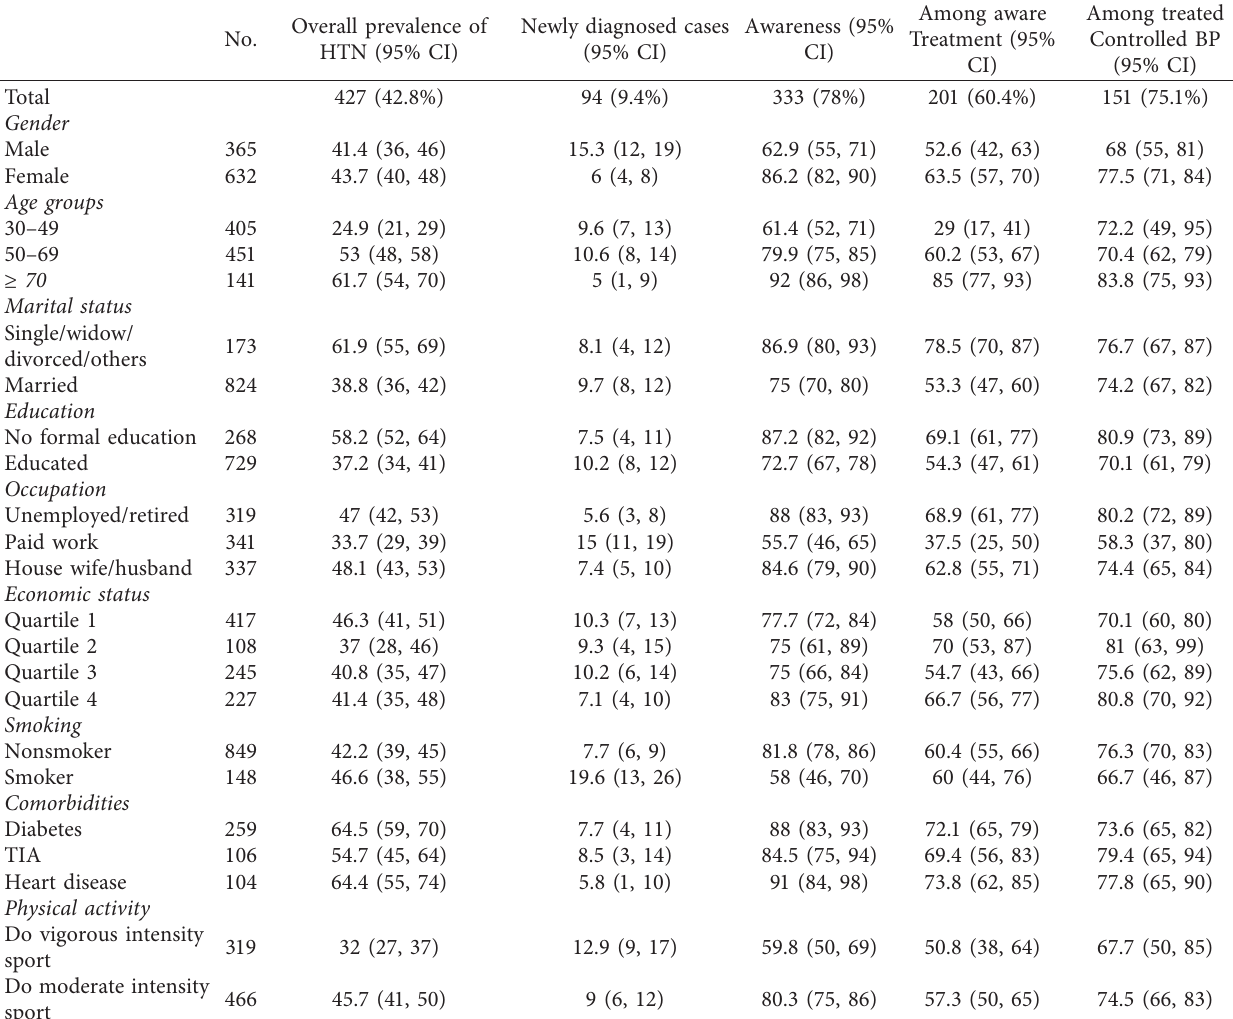
Table 2: Characteristics of SWADES cohort participants by prevalence, treatment, awareness, and control of